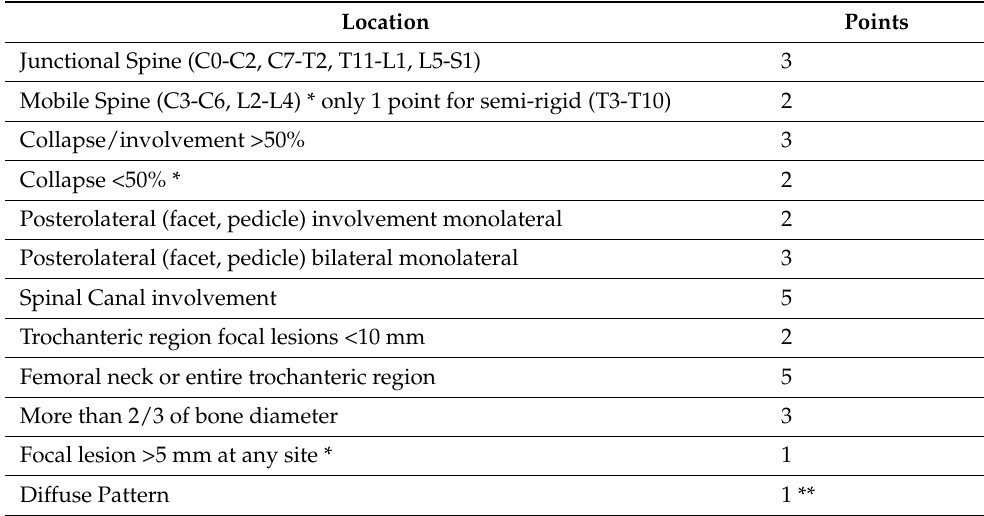
Table 1. MSBDS (Myeloma Spine and Bone Damage Score). Interpretation: High-risk: >10, requiring immediate surgical or radiation oncologist consultation. Medium risk: ≥ 5–10, possible instability and a medium risk of pathological fracture. Low-risk: <5. * Bone abnormalities not sufficient to give high-risk scores, if isolated. ** 1 point for every segment according to MY-RADS